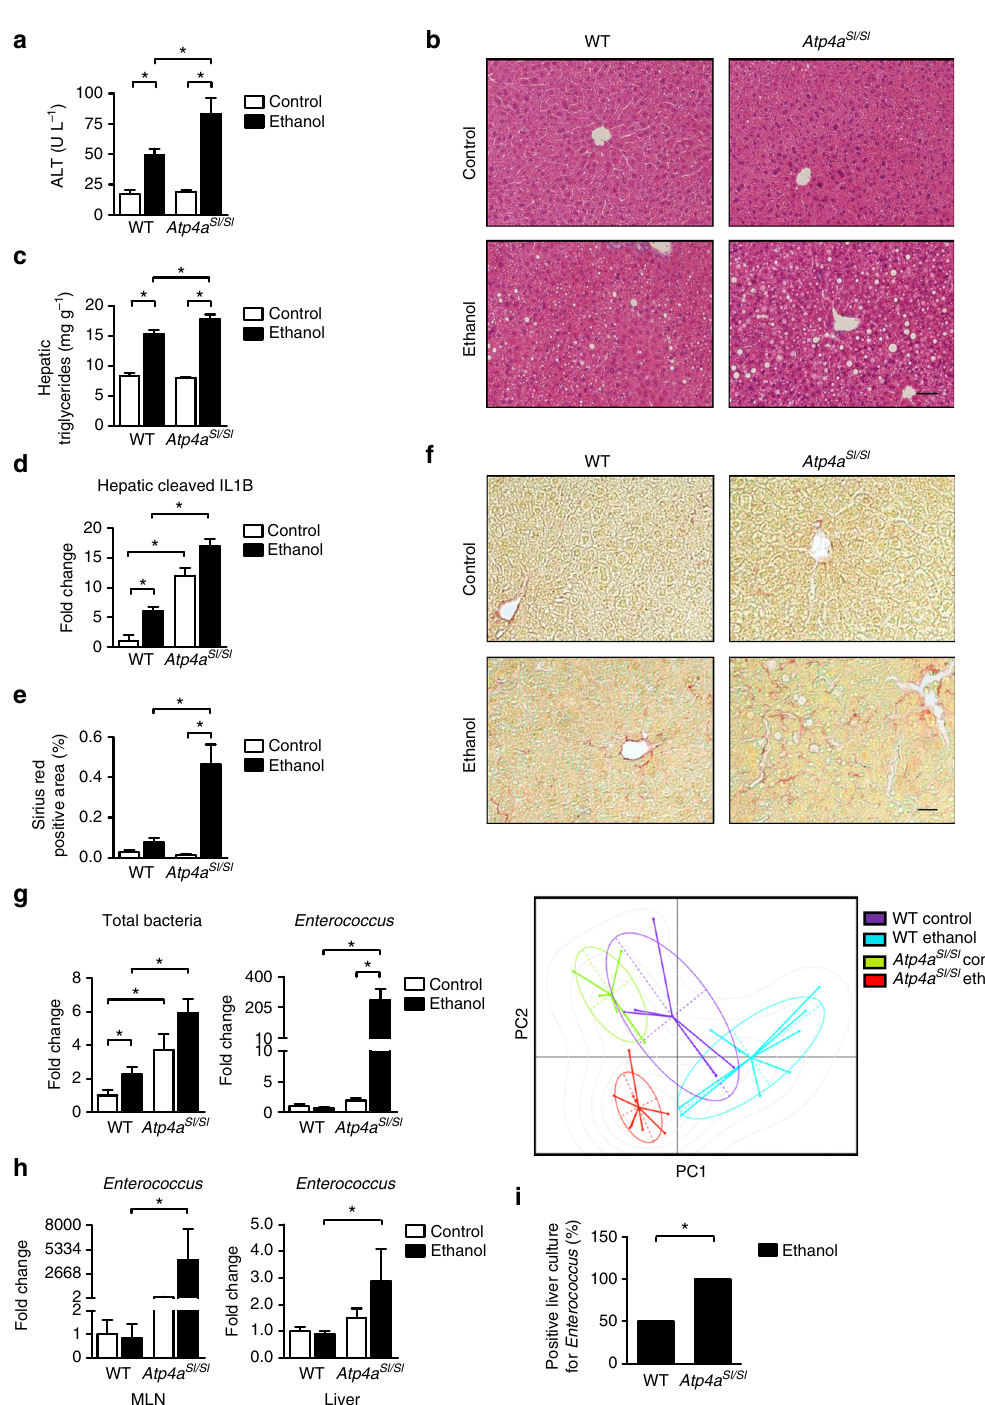
Fig. 1 Genetic deletion of gastric acid secretion exacerbates alcohol-induced liver disease in mice. a – h WT mice and their Atp4a Sl/Sl littermates were fed an oral control diet ( n = 3 – 8; 2 – 3 replicates) or ethanol diet ( n = 6 – 16; 8 – 9 replicates) for 9 weeks following the chronic Lieber DeCarli diet model. a Plasma levels of ALT. b Representative liver sections after hematoxylin and eosin staining. c Hepatic triglyceride content. d Hepatic expression of cleaved IL1B protein ( n = 2 – 5). e Hepatic areas of fi brosis were identi fi ed by staining with Sirius red ( n = 2 – 6); area was quantitated by image analysis software. f Representative Sirius red-stained liver sections. g Total bacteria in feces ( left panel ). Fecal enterococci ( mid panel ). Principal component analysis of fecal microbiomes, performed using the ade4 R package 46 ( right panel ). h Enterococcus in mesenteric lymph nodes (MLN) and liver, assessed by qPCR. i Proportions of positive Enterococcus cultures from liver tissues of WT mice ( n = 6) and their Atp4a Sl/Sl littermates ( n = 11) subjected to chronic-plus-binge ethanol feeding. Results are expressed as mean ± s.e.m. Scale bars = 100 μ m. For a , c , d , e , g , h signi fi cance was evaluated using the unpaired Student t -test or Mann – Whitney U -statistic test. For i , signi fi cance was evaluated using Fisher ’ s exact test.* P <